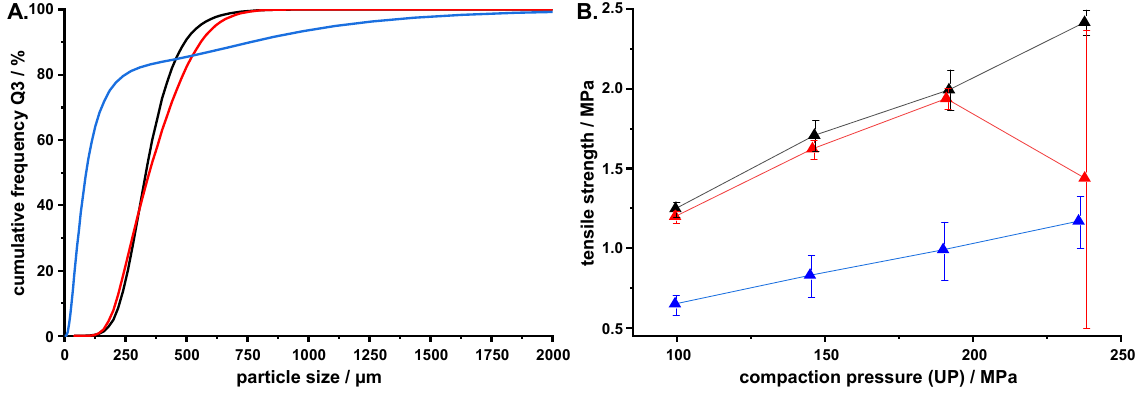
Figure 9. ( A ) PSD ( n = 1, entire batch); ( B ) tensile strength of tablets produced ( n = 6, mean ± s) from QESD MF using different hypromellose types as polymeric stabilizers (black: Pharmacoat ® 603, red: Methocel™ K4M) compared to the freshly milled reference material (blue).